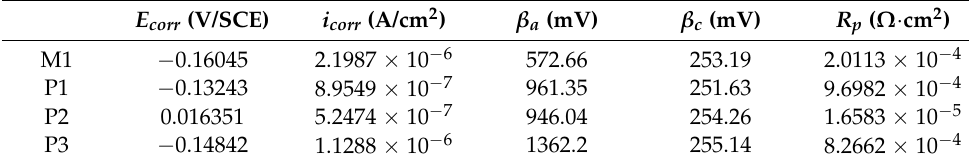
Table 5. Corrosion parameters of milling and electrochemical polishing